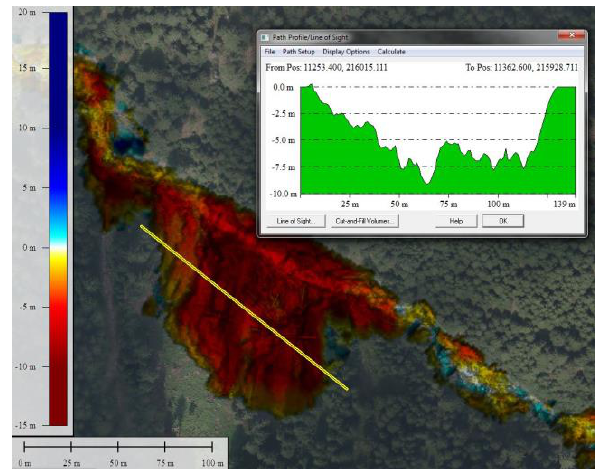
Figure 11. Ortho photo detail overlaid by terrain changes in the upper section of the torrent. The profile direction is from northwest to southeast.